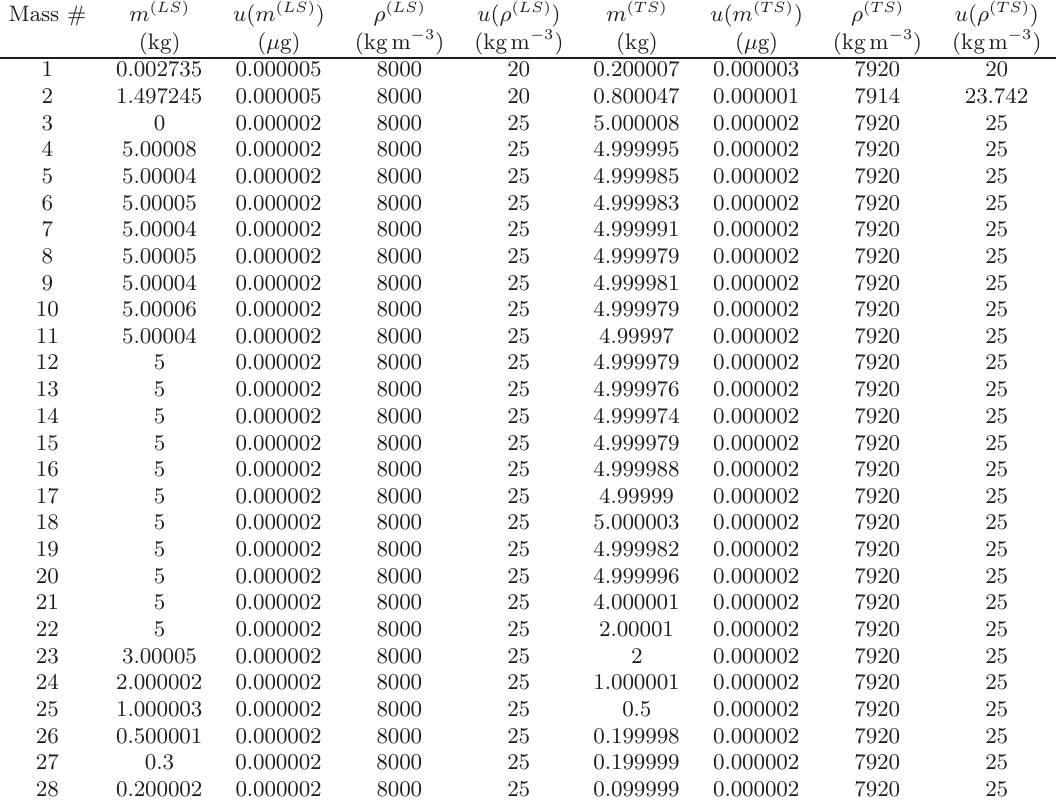
Table 1. Laboratory standard and transfer standard mass piece values where mass piece #1 and mass piece #2 correspond to the piston and bell masses respectively.